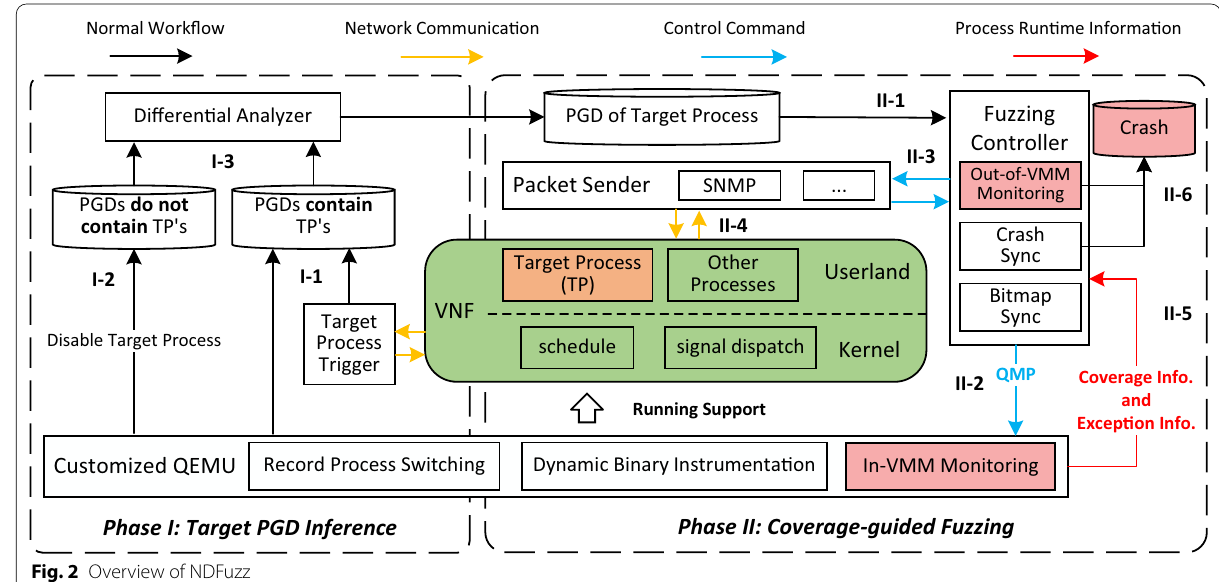
Fig. 2 Overview of